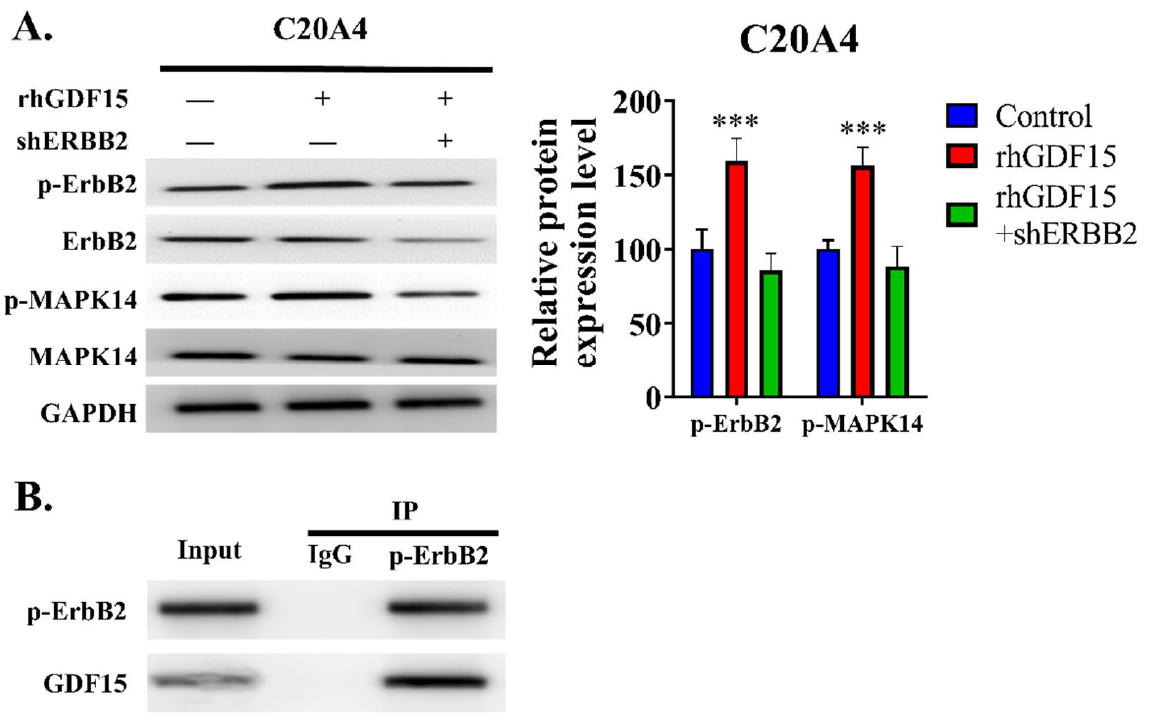
Figure 6. GDF15 interacts with ErbB2 in chondrocytes. ( A ) Western blot protein analysis of ErbB2, pErbB2, MAPK14, and pMAPK14 in C20A4 cells treated with or without recombinant human GDF15 (rhGDF15; 10 ng/mL) for 24 h and shERBB2. ( B ) GDF15 was immunoprecipitated from the cell lysates of IL-1 β -induced C20A4, and the immunoprecipitation product was immunoblotted with an anti-p-ErbB2 antibody. *** p <